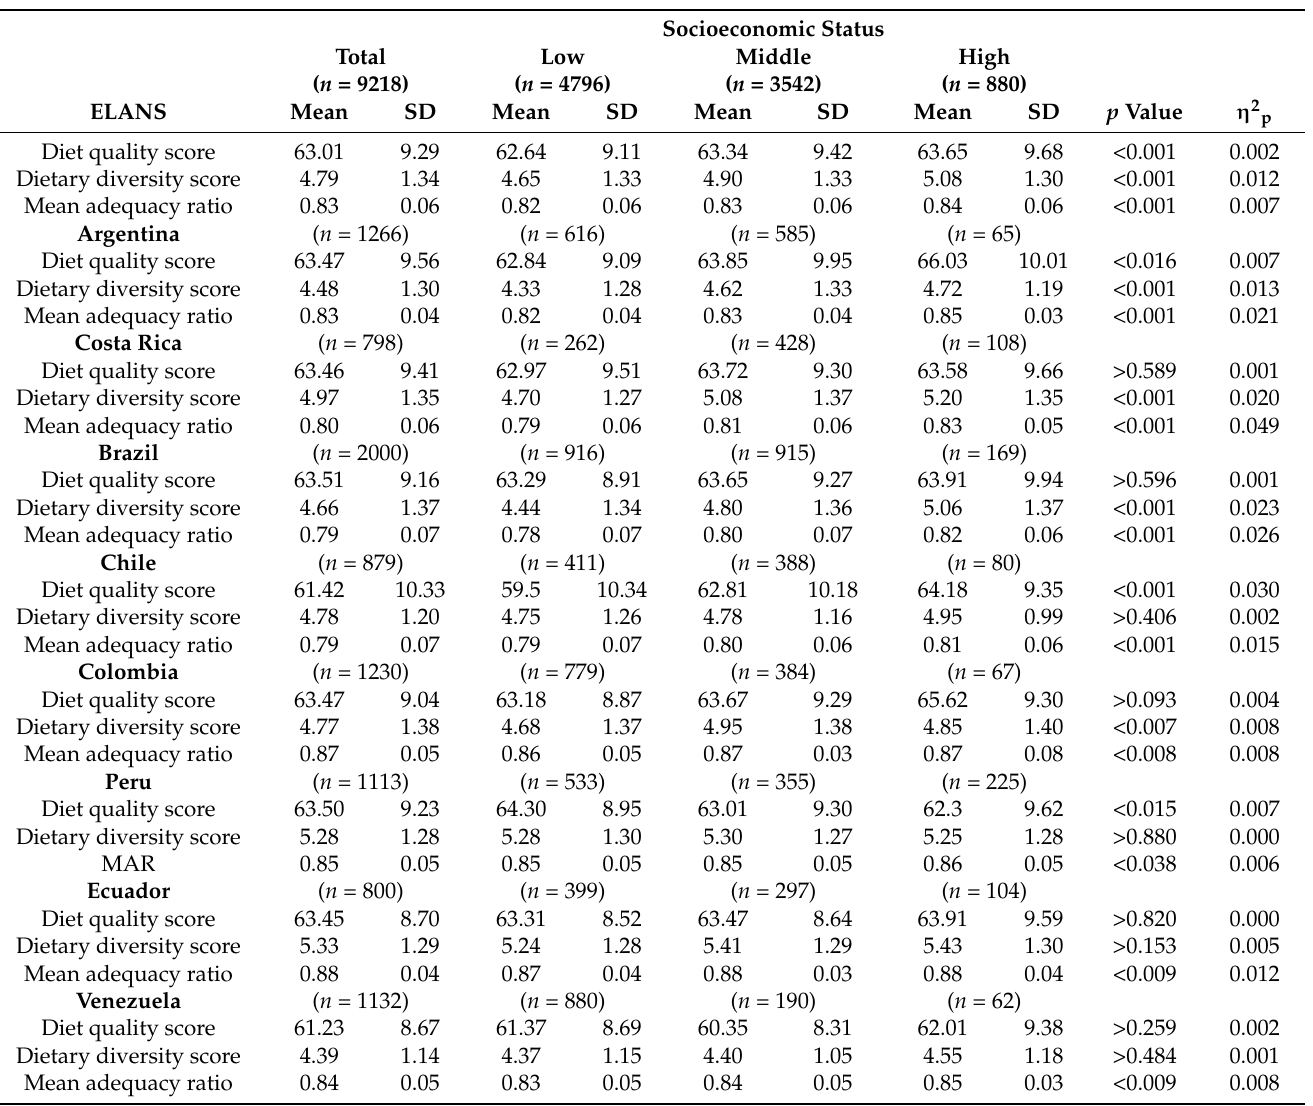
Table 4. Diet quality indicators by country according to socioeconomic status—the Latin American Health and Nutrition Study